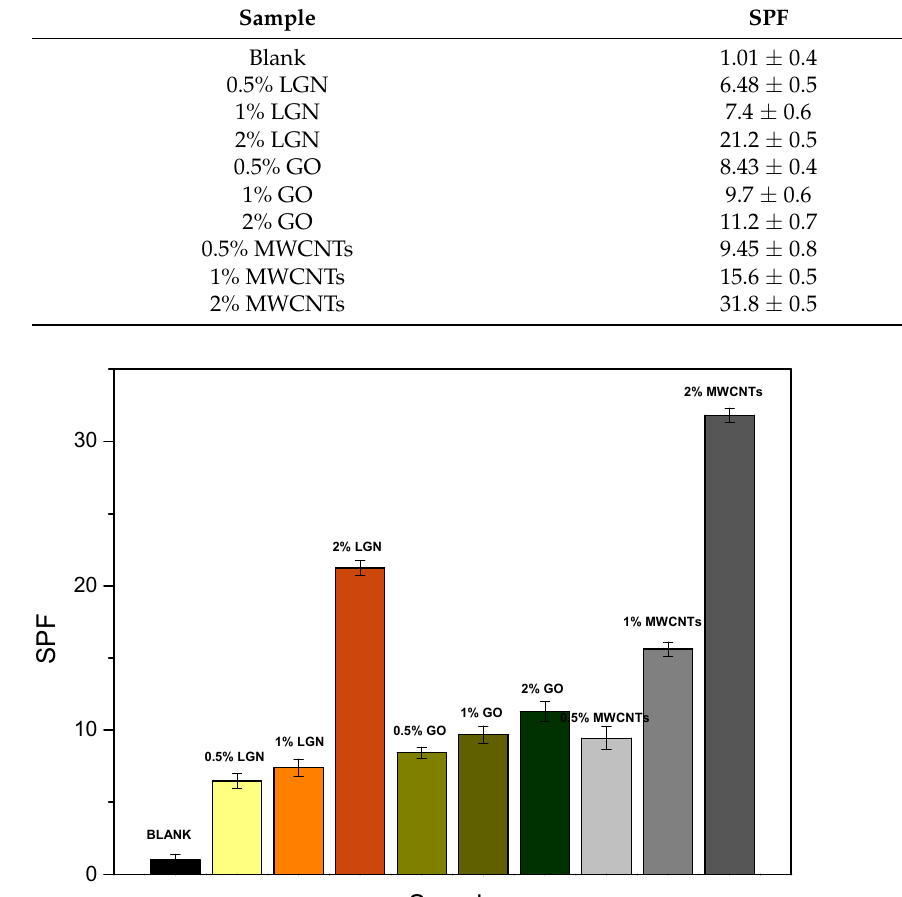
Figure 6. Sun protection ability of the emulsions.